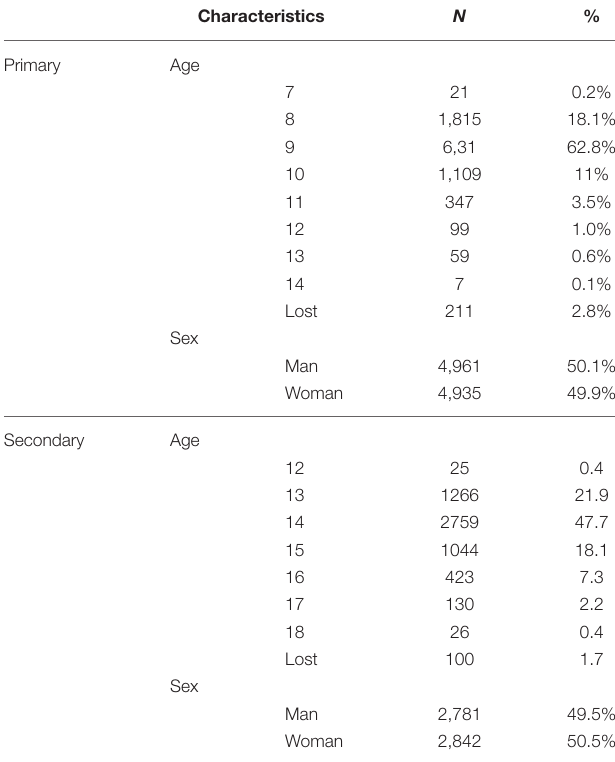
TABLE 1 | Demographic characteristics of the